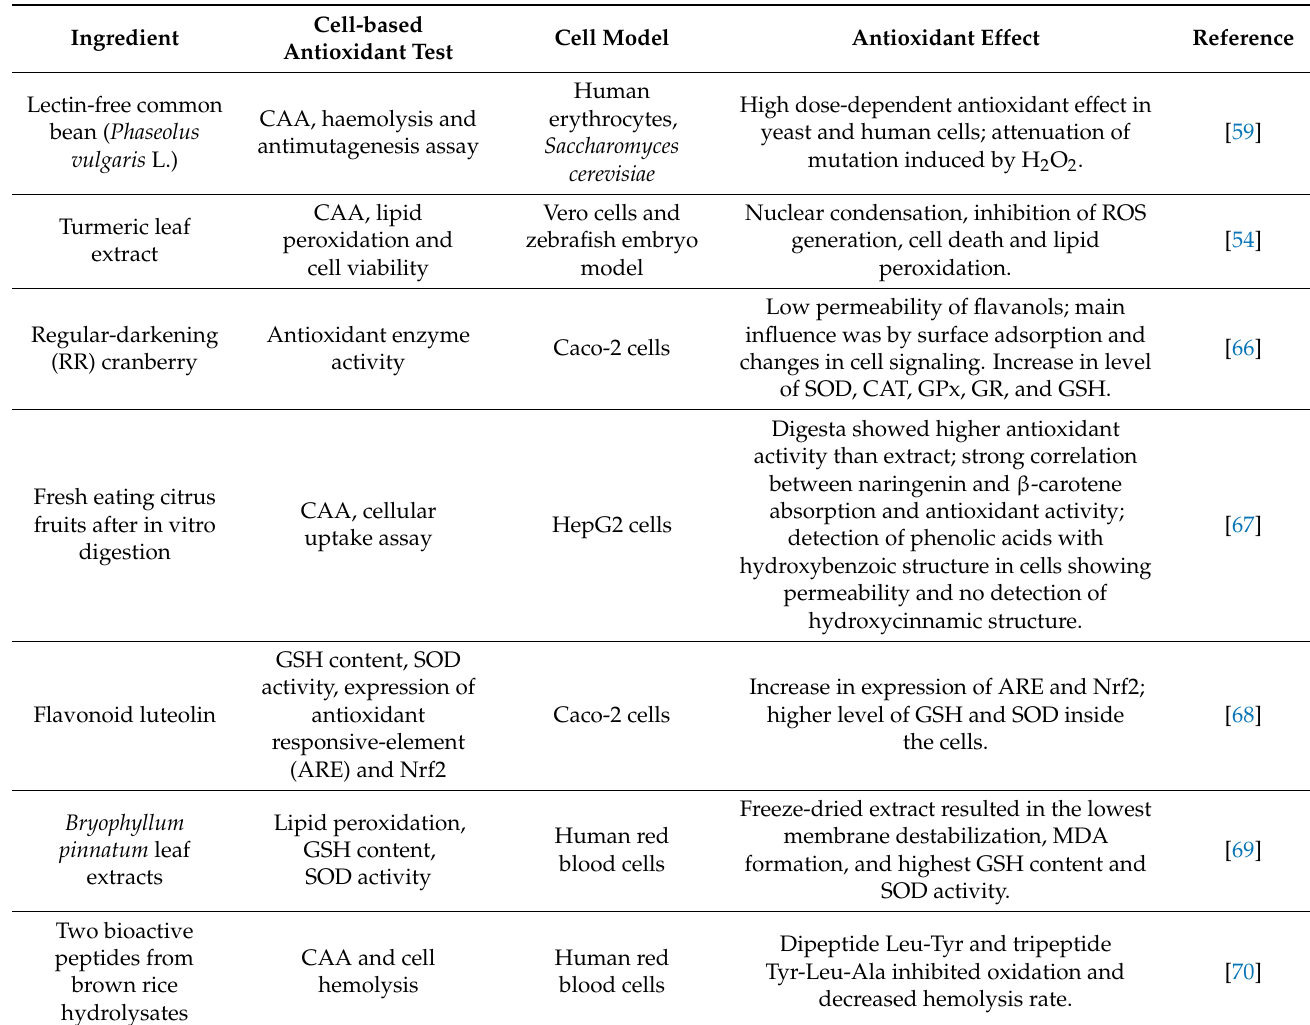
Table 1. Recent cell-based antioxidant assays for food-derived antioxidant